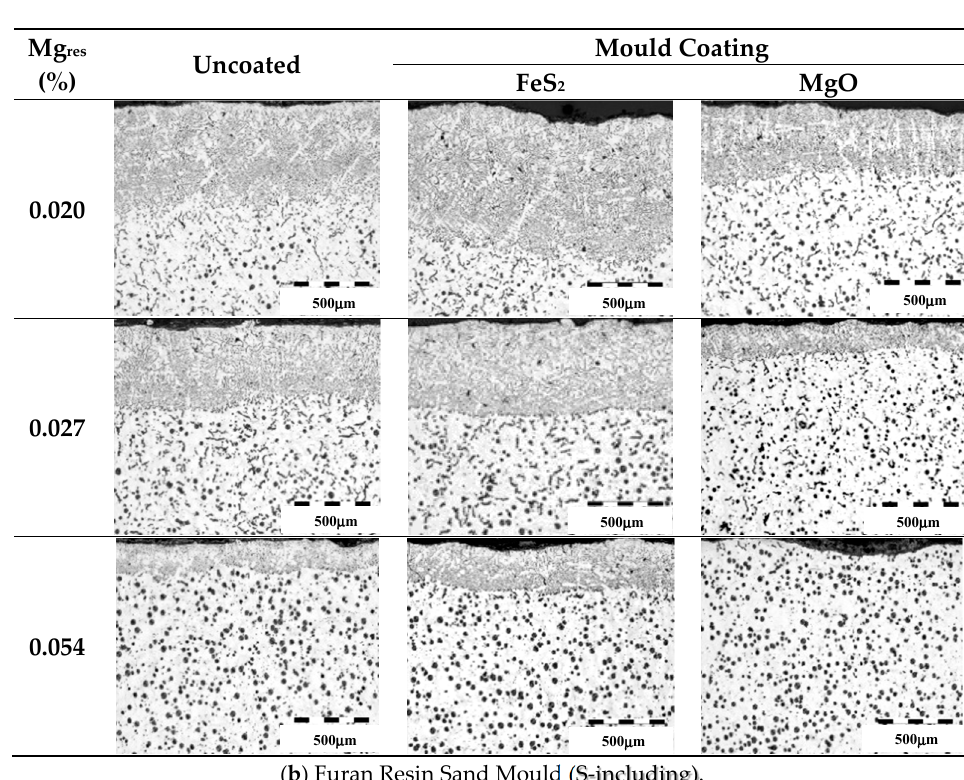
Figure 1. General view on the surface casting layer (skin) graphite structure (un-etching) at different Mg res content, in the mould without ( a ) and with sulphur content ( b ) and un-coated and FeS 2 or MgO bearing coatings.